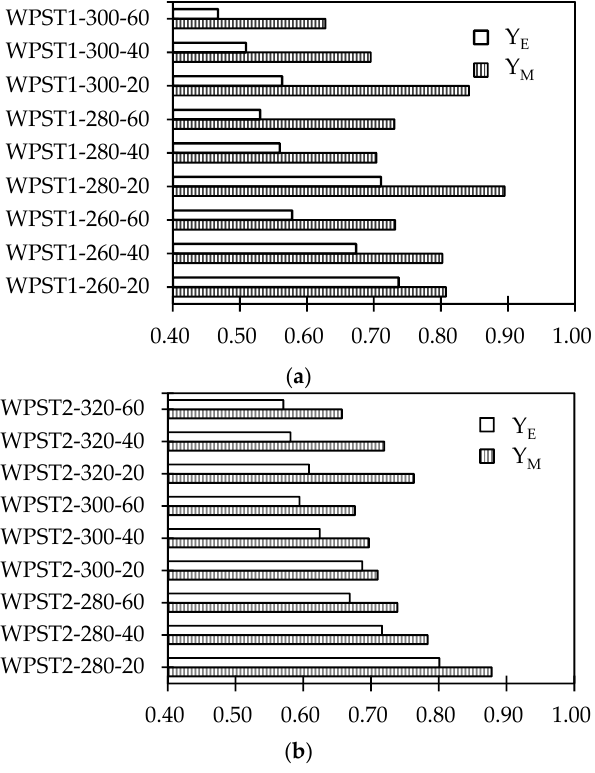
Figure 4. Energy yield (Y E ) and mass yield (Y M ) at different torrefaction conditions for ( a ) WPST1 and ( b ) WPST2. Table 3. Energy densification ratios E D of WPS at various torrefaction temperatures.